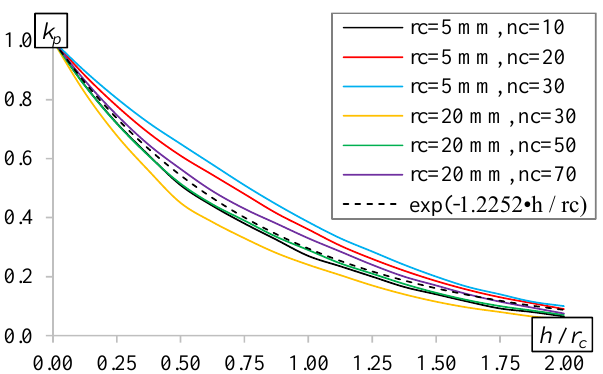
Figure 7. Periodic coupling coefficient, k p , for considered coils and different h / r c.